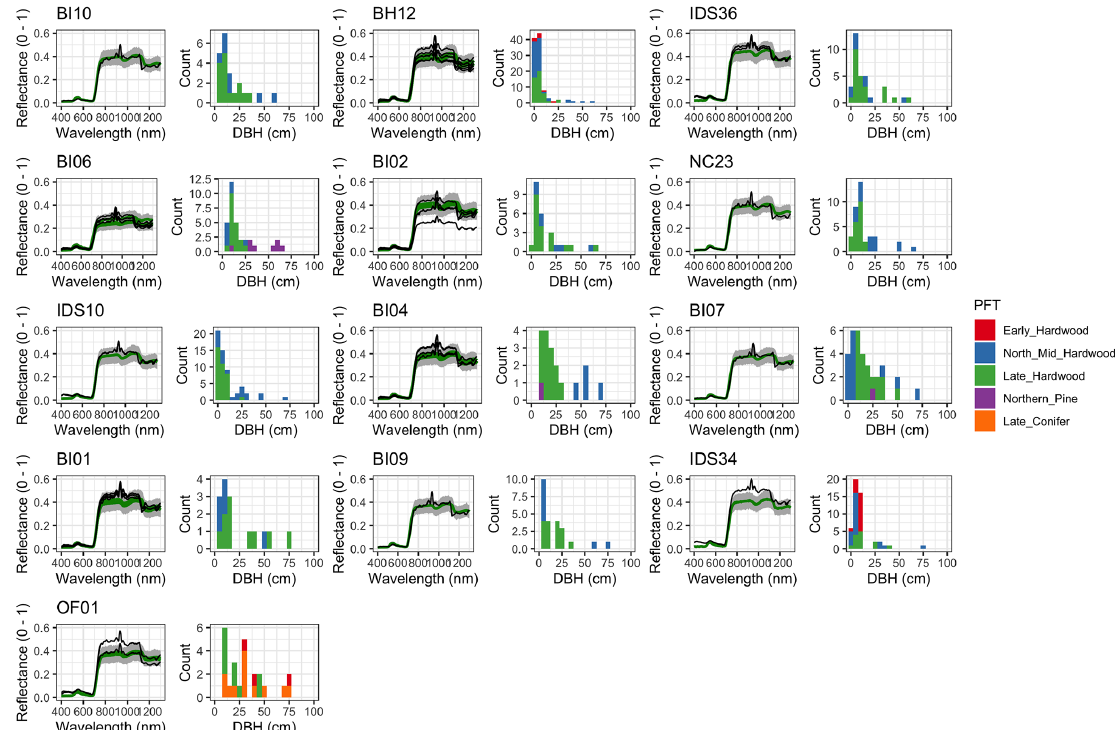
Figure A10. As above but for the fourth quartile of sites by